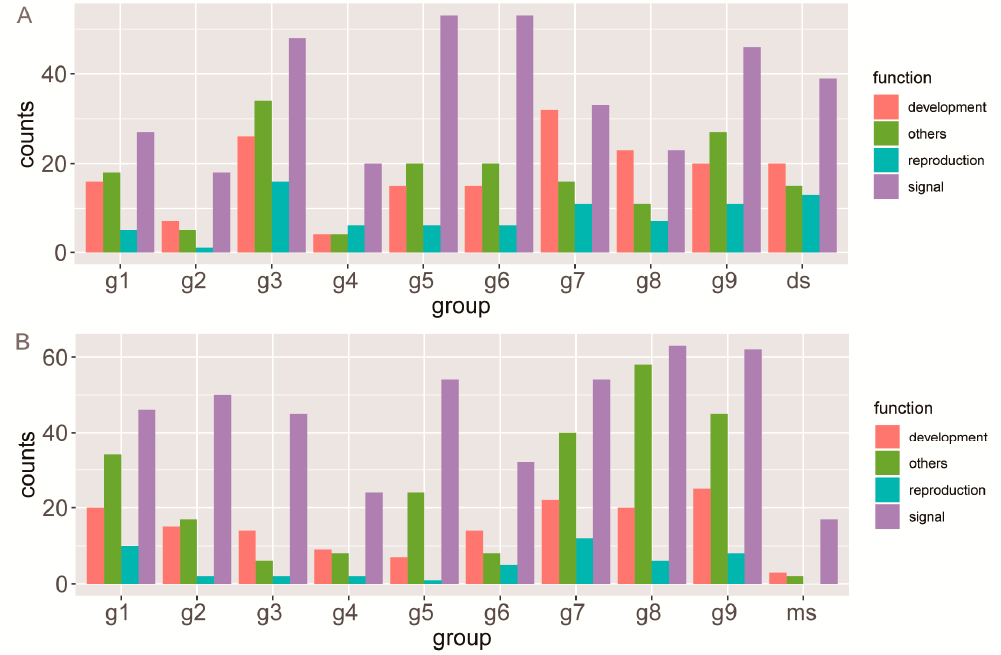
Figure 6. Gene Ontology (GO) enrichment of the predicted binding transcription factors (TFs) upstream in each group. ( A ) GO enrichment of dicots. ( B ) GO enrichment of monocots.